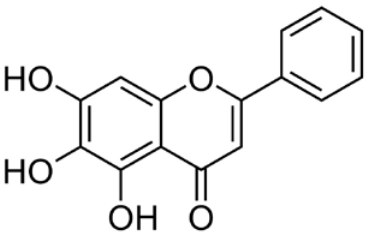
Figure 1. Structural formula of the baicalein flavonoid.